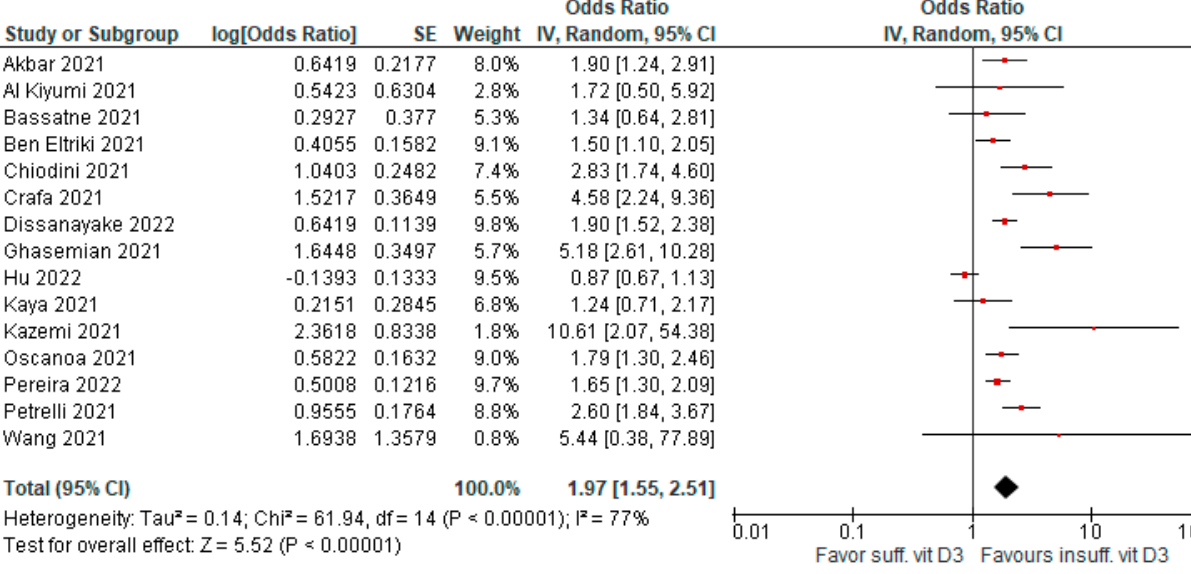
Figure 3. Forest plot showing results for the association of vitamin D3 levels and COVID-19 severity.